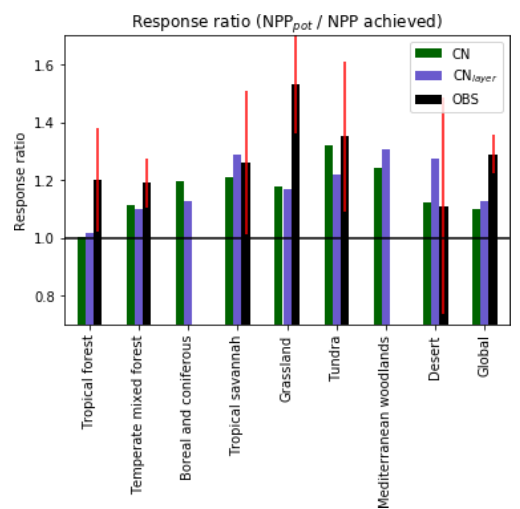
Figure 10. The response ratio is the ratio of the potential amount of carbon that can be allocated to growth and spreading of the vegetation (NPP pot ) compared with the actual amount achieved in the natural state (NPP). As in Fig. 9, any grid cells with an an- nual NPP of less than 0.016gCm − 2 are set to missing. The me- dian of JULES-CN and JULES-CN layer are shown for each biome for the period 1996–2005. The biomes are discussed in more de- tail in Fig. 8. The observational constraint is taken from Table 1 in LeBauer and Treseder (2008), which summarises a meta-analysis of nitrogen addition experiments. The black bars show the mean of the observations, and the red lines show the